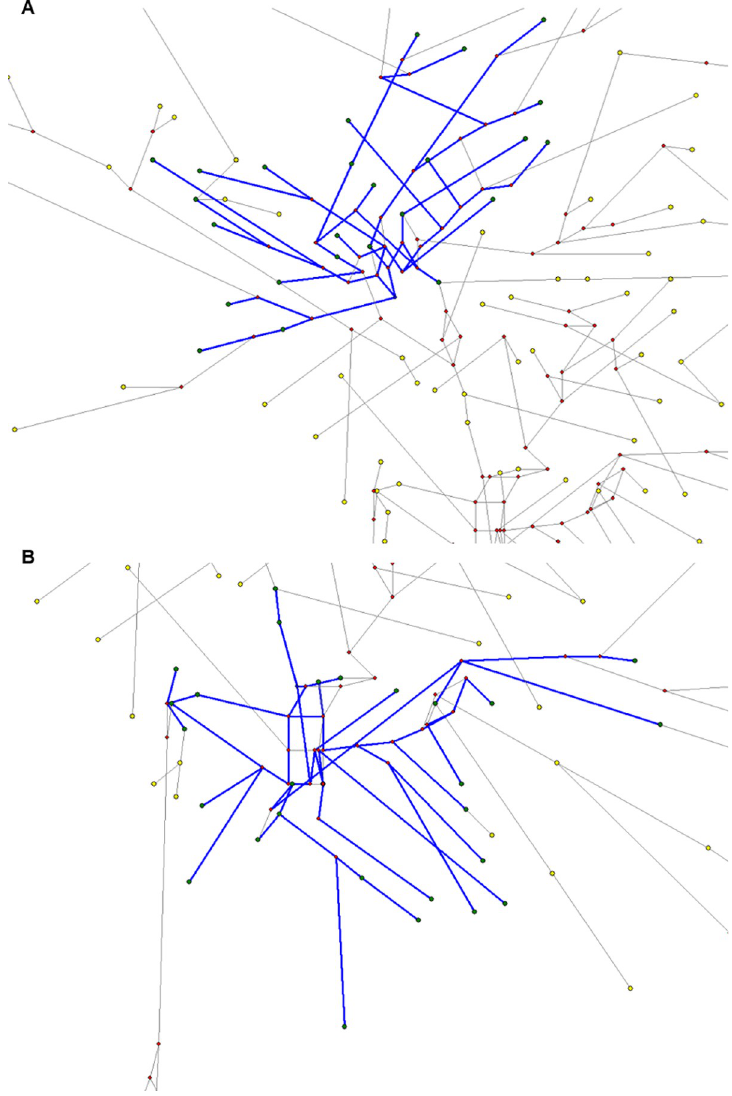
Fig 5. Estimation of the time of expansion events between all Cypriots. (A) First expansion event among Armenian Cypriots, Greek Cypriots and Turkish Cypriots, (B) Second expansion event between all Cypriots. Yellow circles represent the Y-haplotypes, the red circles represent the median vectors and the blue lines are the Y-haplotypes, which consist the expansion